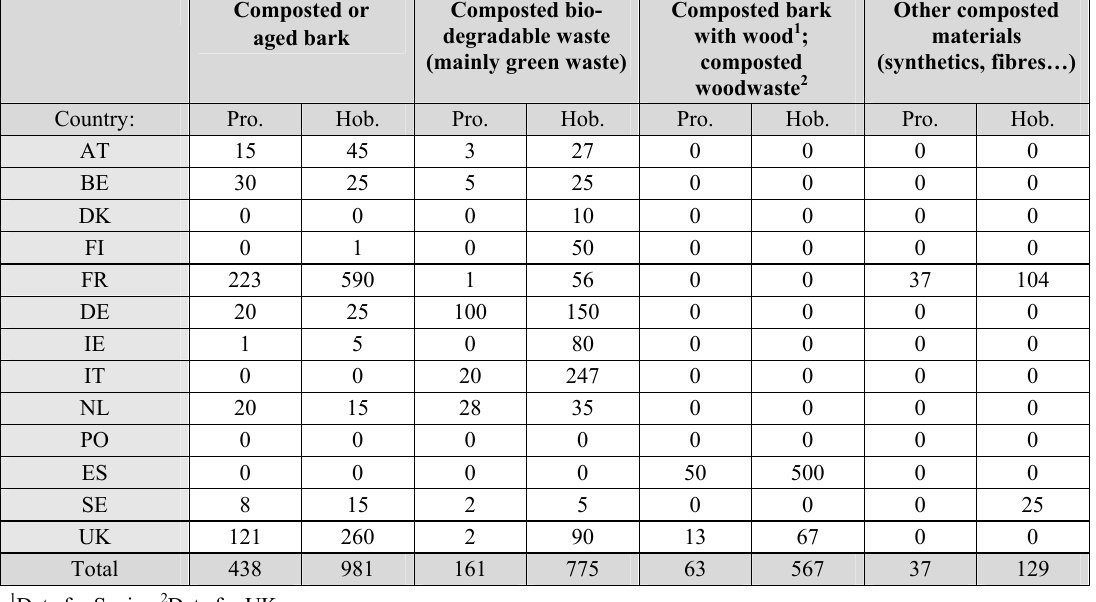
Table 40: Amounts of composted materials (in m³ in 1000 t according to EN 12580) used for the production of growing media in major producer countries in the EU (Pro = professional market; Hob = hobby